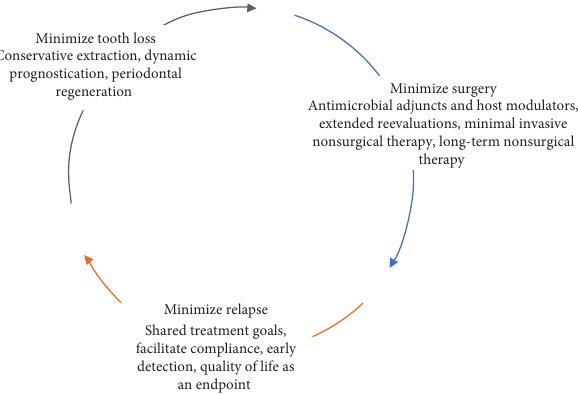
Figure 1: The minimally invasive approach to periodontology involves three interlinked goals. This aims to minimize tooth loss at the initial stage and minimize surgery by considering the use of adjuncts and appropriate evaluation periods. If indicated, regen- erative surgery with a minimally invasive approach may improve attachment levels. Minimizing relapse will in turn minimize tooth loss and improve the quality of